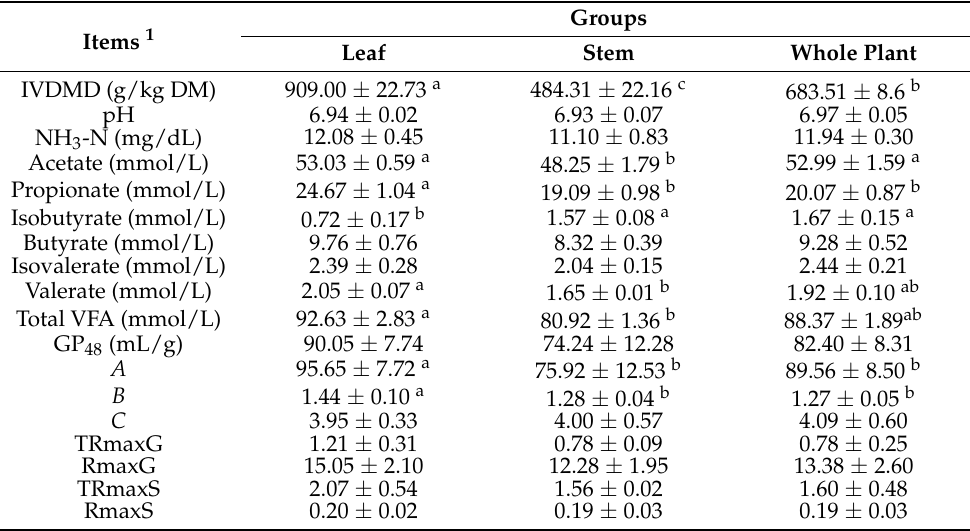
Table 4. The IVDMD, in vitro gas production kinetics, and rumen fluid fermentation profile of different parts of paper mulberry silage.